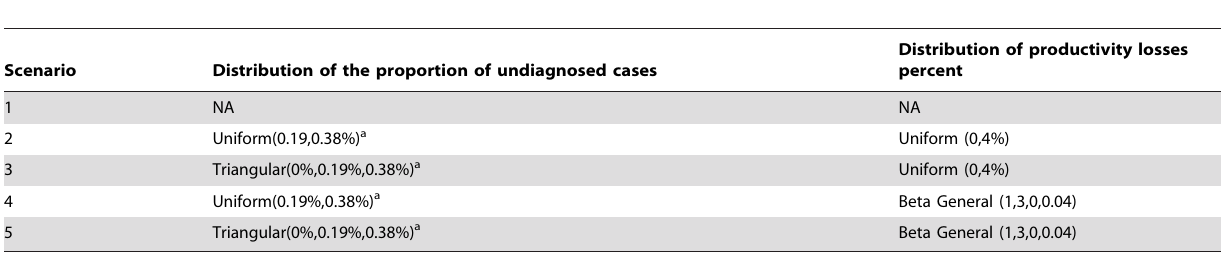
Table 6. Sensitivity analyses and conditions used to estimate the economic losses associated with CE in humans and livestock (sheep and cattle), A´lava, 2005.